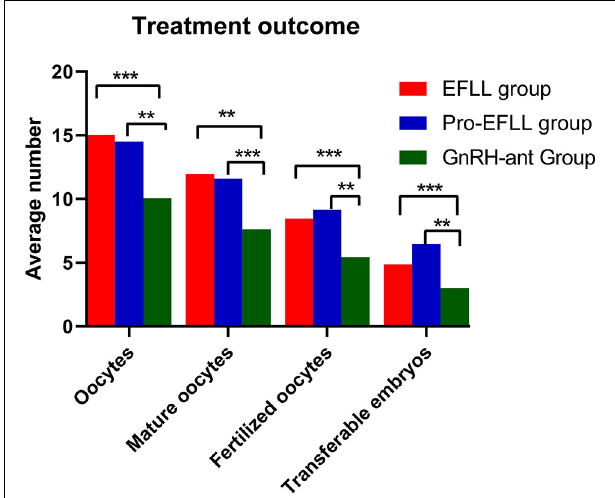
FIGURE 5 | Comparison of oocytes retrieved, mature oocytes, fertilized oocytes, and transferable embryos among EFLL, Pro-EFLL, and GnRH-ant protocol. Values are presented as mean ± standard deviation. **Represents significant difference at P < 0.01, ***represents significant difference at P < 0.001.